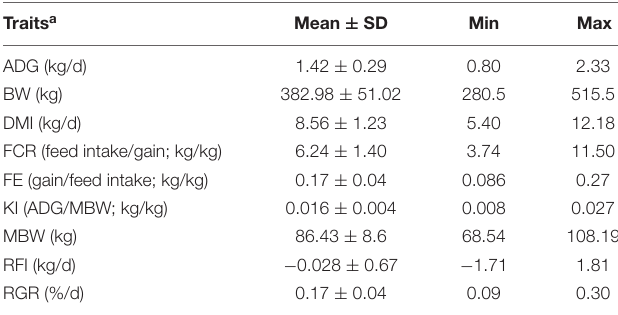
TABLE 1 | Mean, standard deviation (SD), minimum (Min), and maximum (Max) observed values for feed efficiency-related traits in Nelore cattle. Traits a